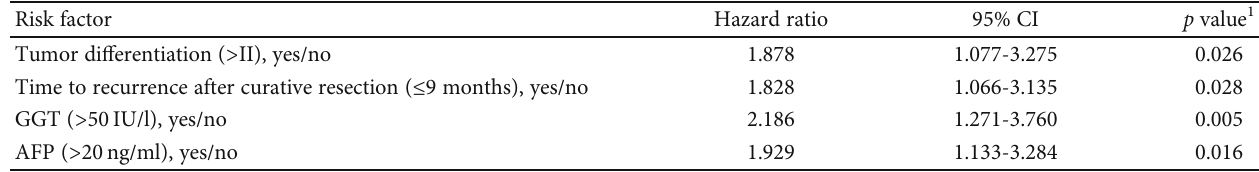
Table 2: Multivariate analysis of the factors associated with OS of recurrent HCC patients undergoing RFA.